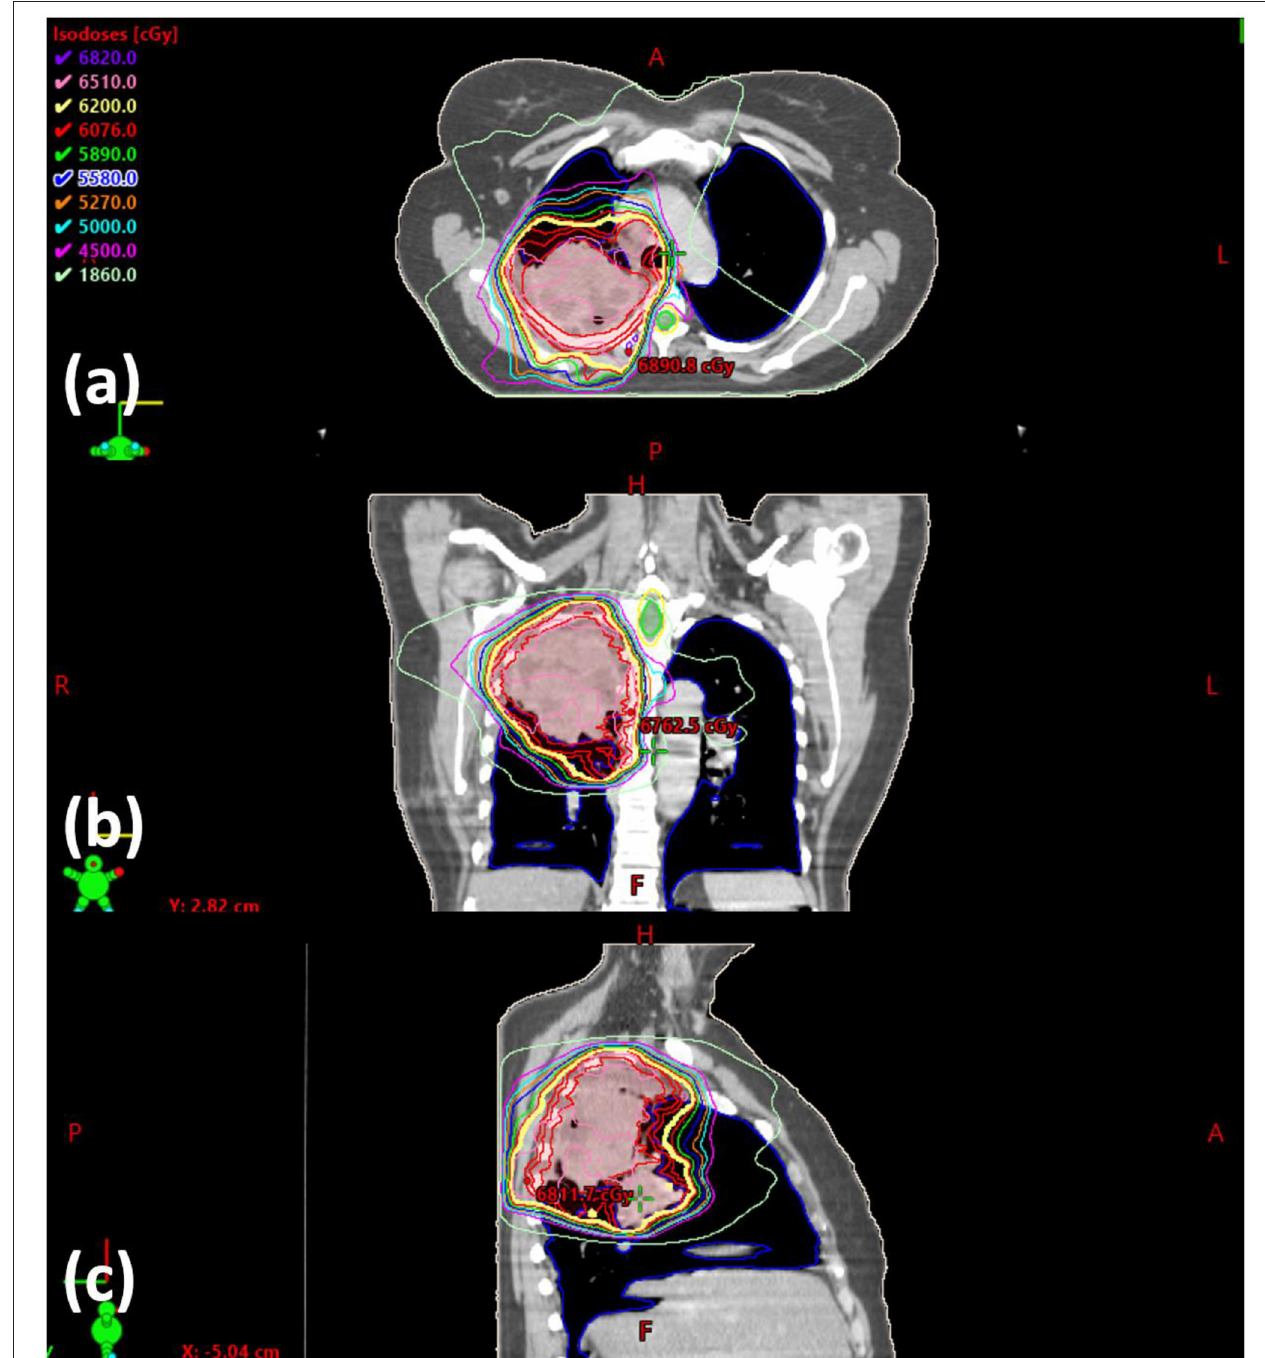
FIGURE 3 | Screenshot of the benchmark case in (a) axial, (b) coronal, and (c) sagittal view. The clinically delivered plan’s isodose is displayed.